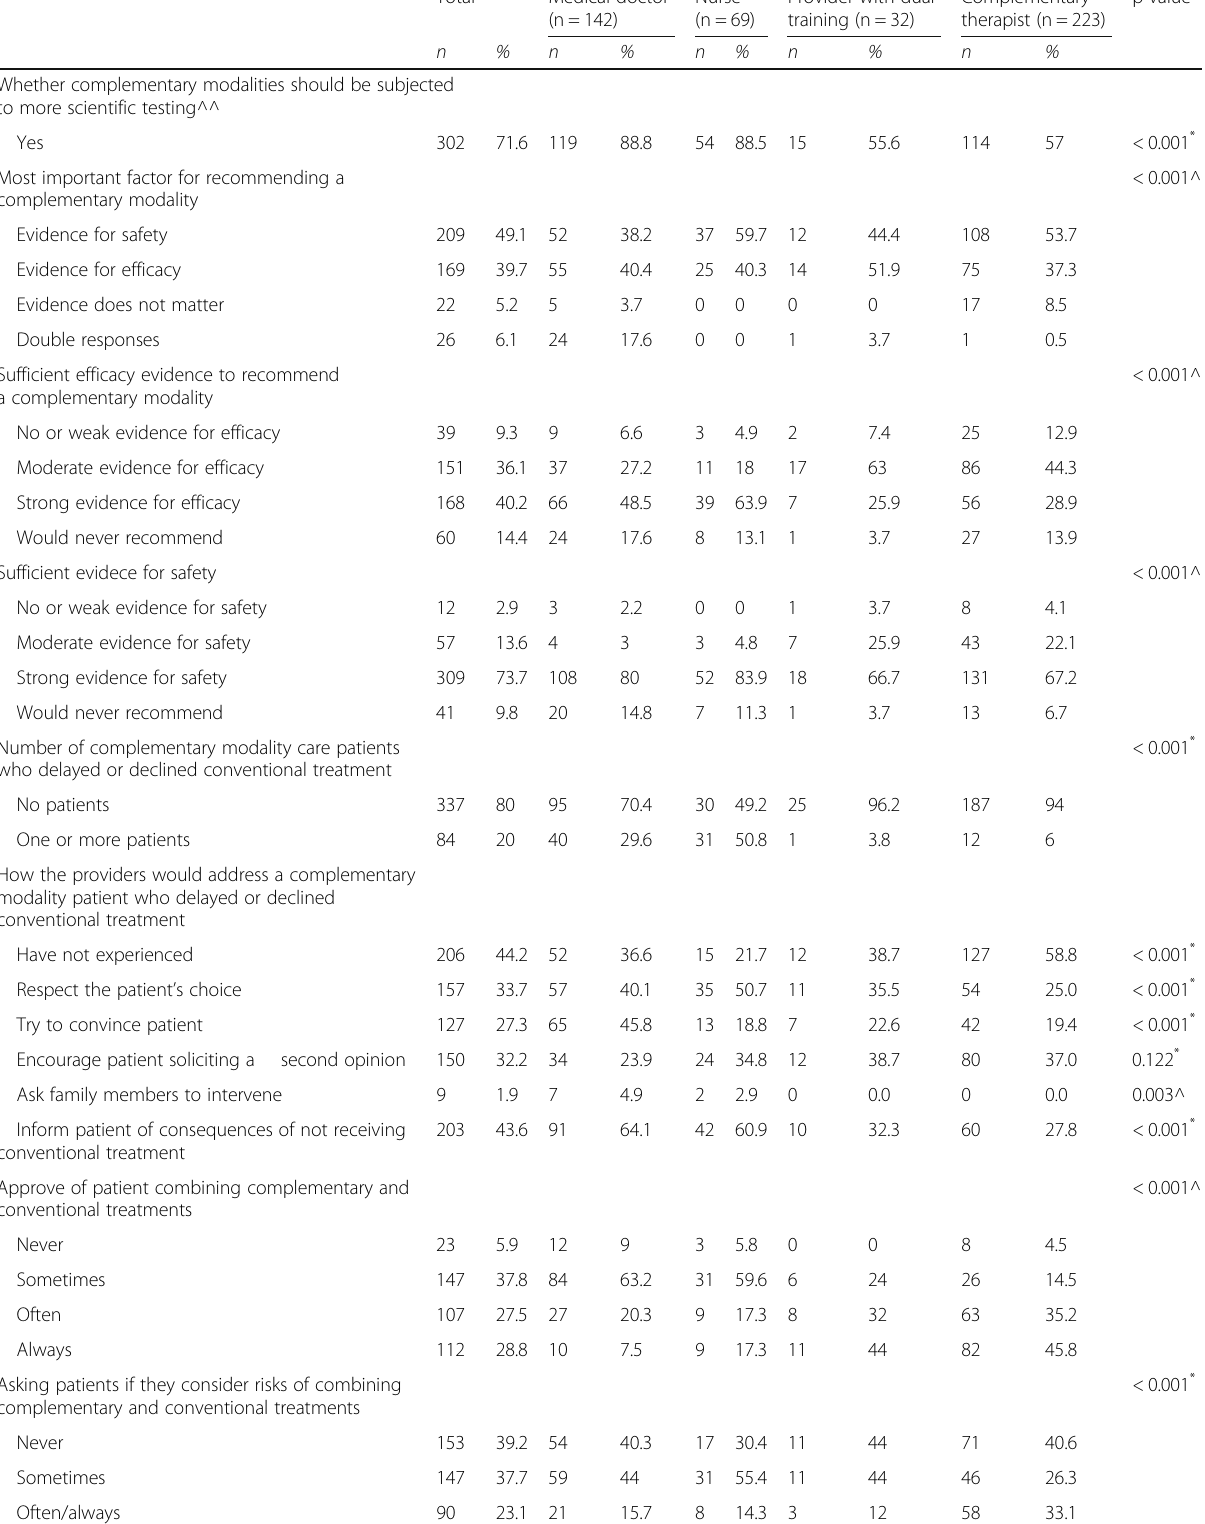
Total Medical doctor